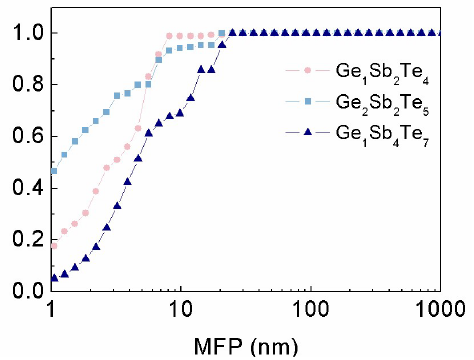
Figure 7. Normalized cumulative thermal conductivity of h -GST phases at 300 K.